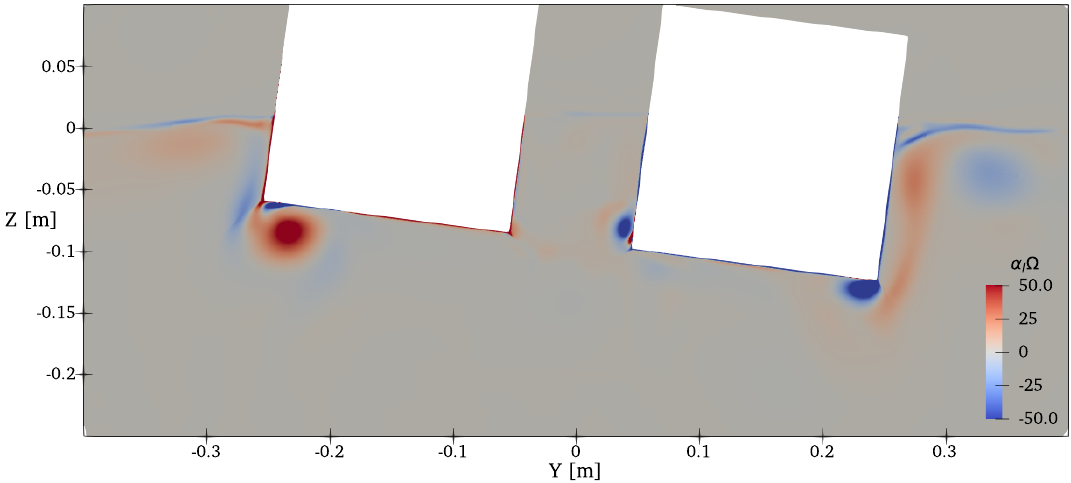
Figure 11. Vorticity contours multiplied by the volume fraction near the moonpool-type structure. The wave steepness is H / λ = 1/30 and the period is T = 0.95